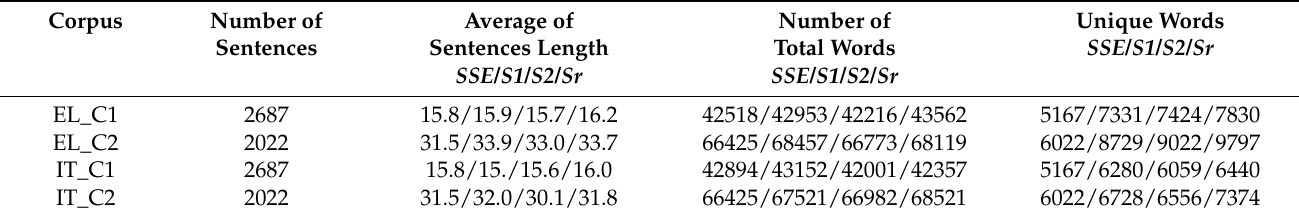
Table 1. Corpora details on the two machine translation (MT) outputs ( S1 for the Statistical Machine Translation (SMT) output and S2 for the Neural Machine Translation (NMT) output) SSE for the source sentences and the Sr .